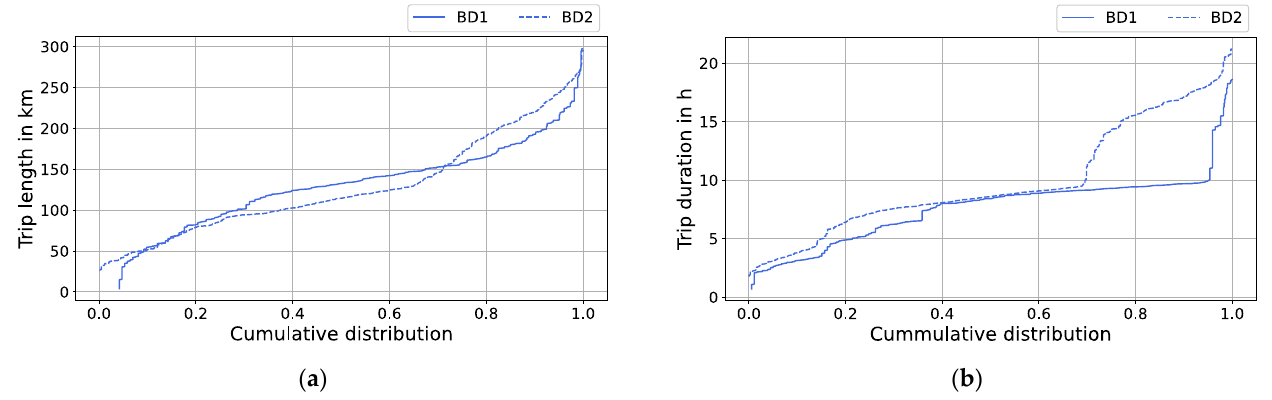
Figure 1. Cumulative distribution of the ( a ) trip length and ( b ) trip duration for the two analyzed depots. Adapted with permission from Ref. [4]. Copyright 2021, IEEE.